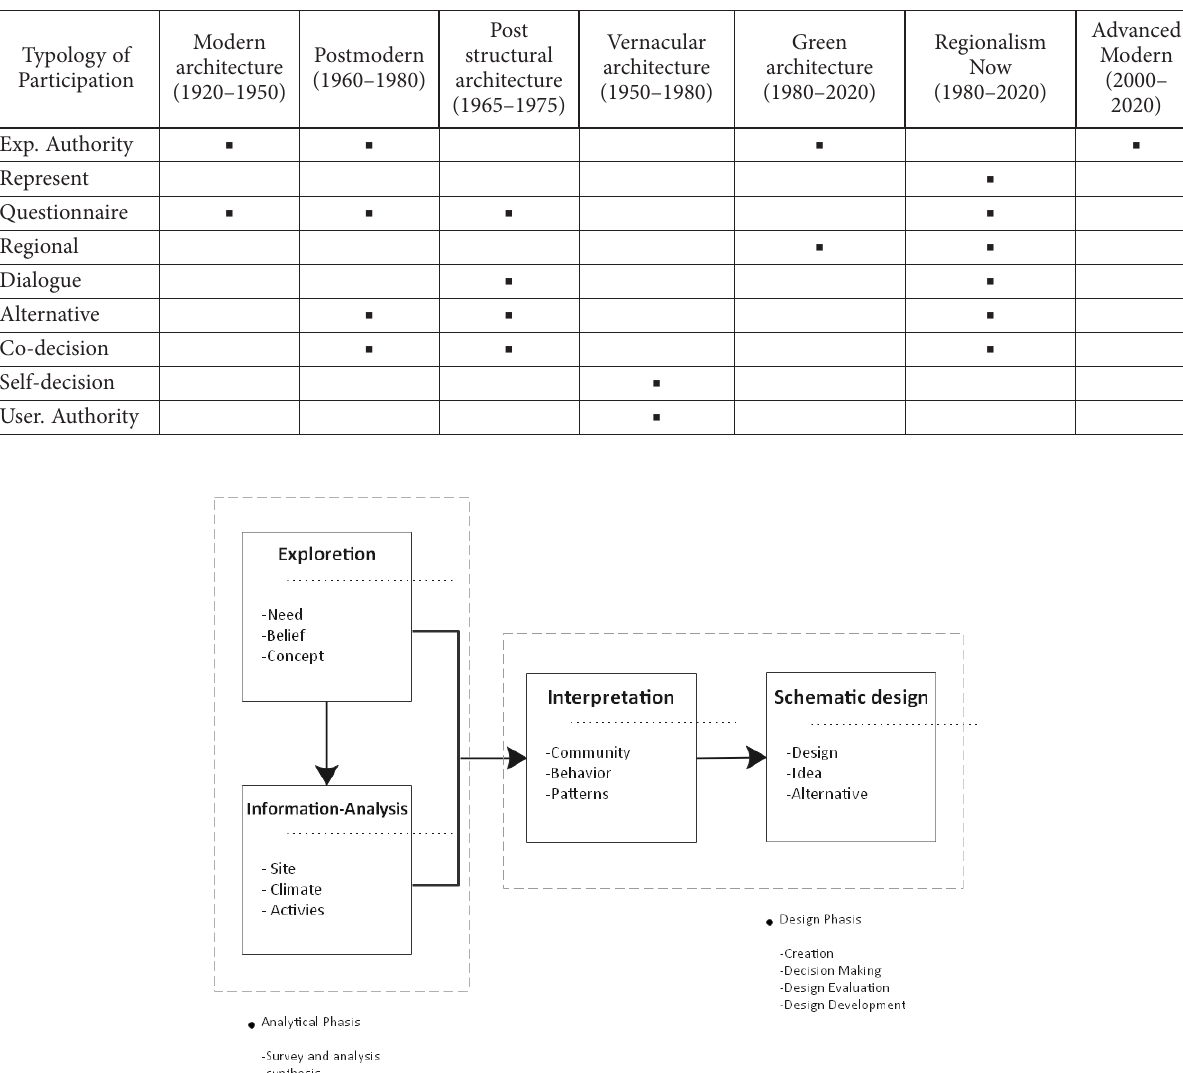
Table 5. Participatory typologies of architecture in contemporary ages (based on Wulz (1986) classification) (source: authors)